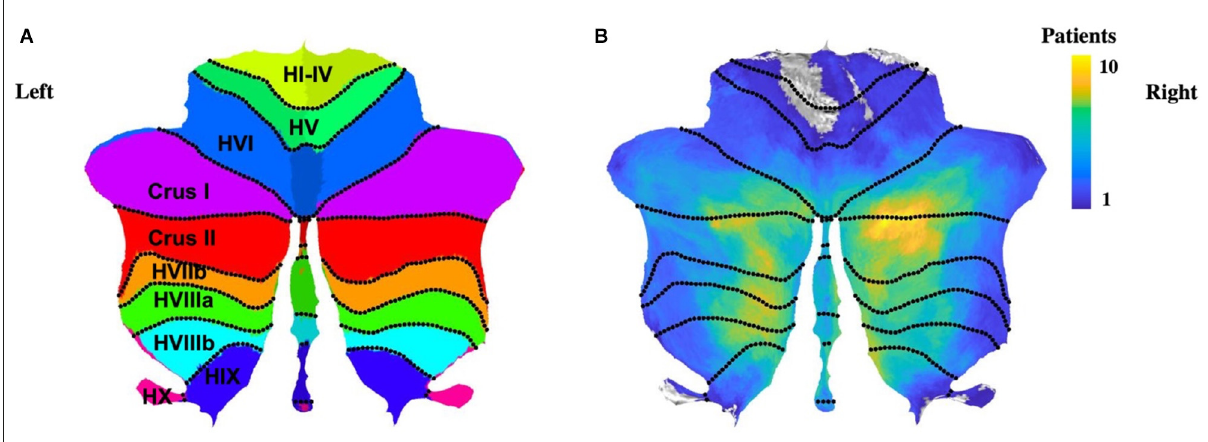
FIGURE3 Flattened representation of the cerebellum (A) and the patients’ lesion distribution in this Study (B) .